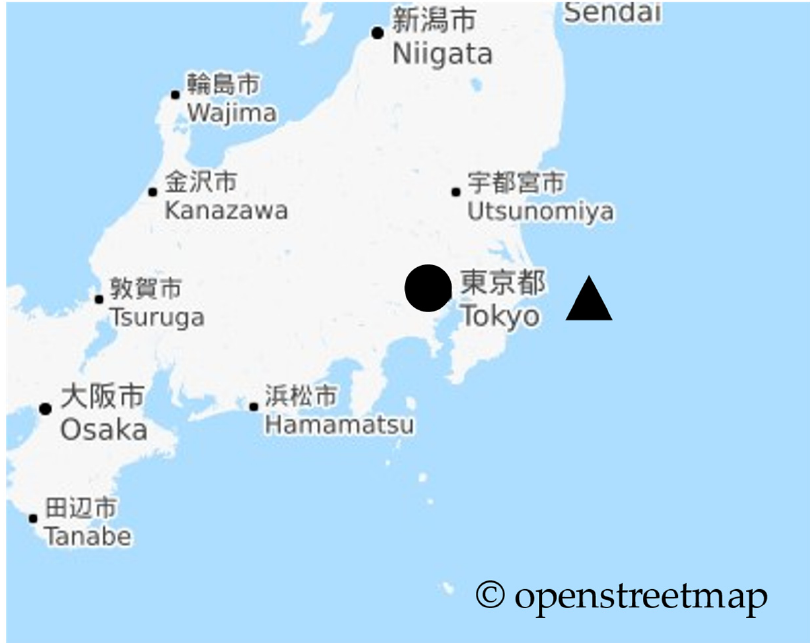
Figure 2. Facility and assumed offshore location in Japan [42].